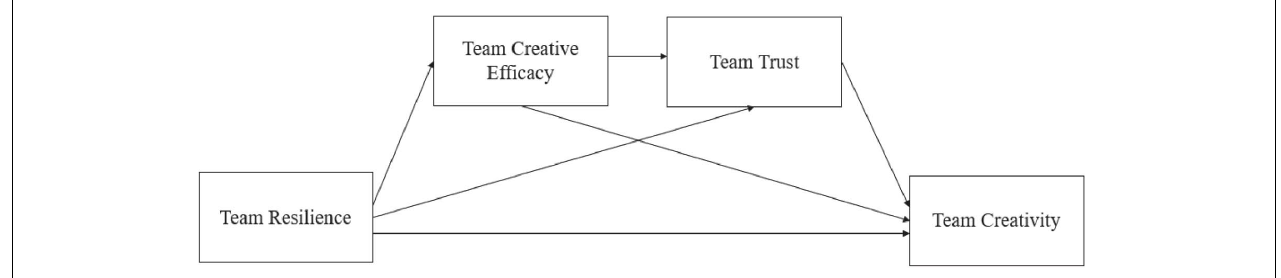
FIGURE 1 | Proposed sequential mediation